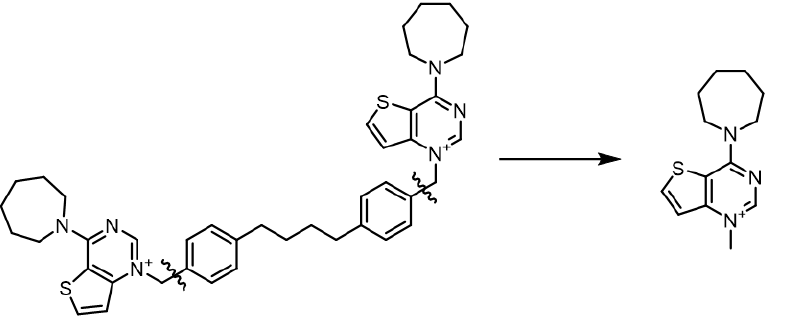
Figure 2. Example of the simplification of the structure to submit to the QM calculations. Fa-29 ( left ) and the portion submitted to QM calculations ( right ). and the portion submitted to QM calculations ( right